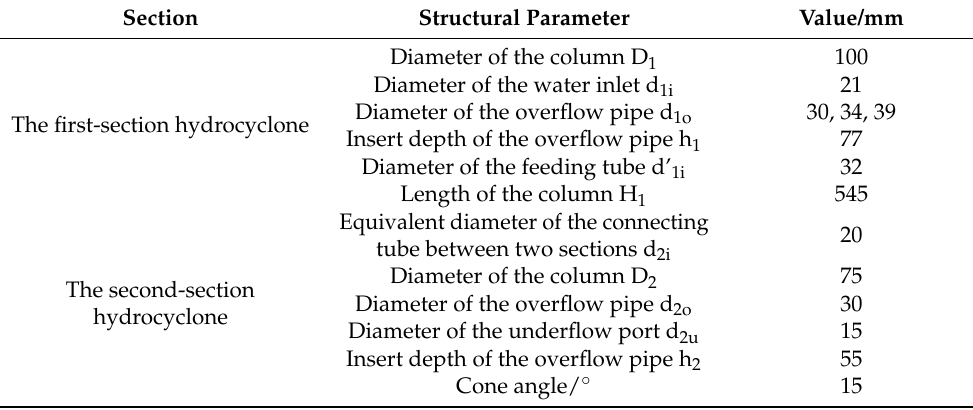
Table 1. Main structural parameters of the hydrocyclone sand washer.